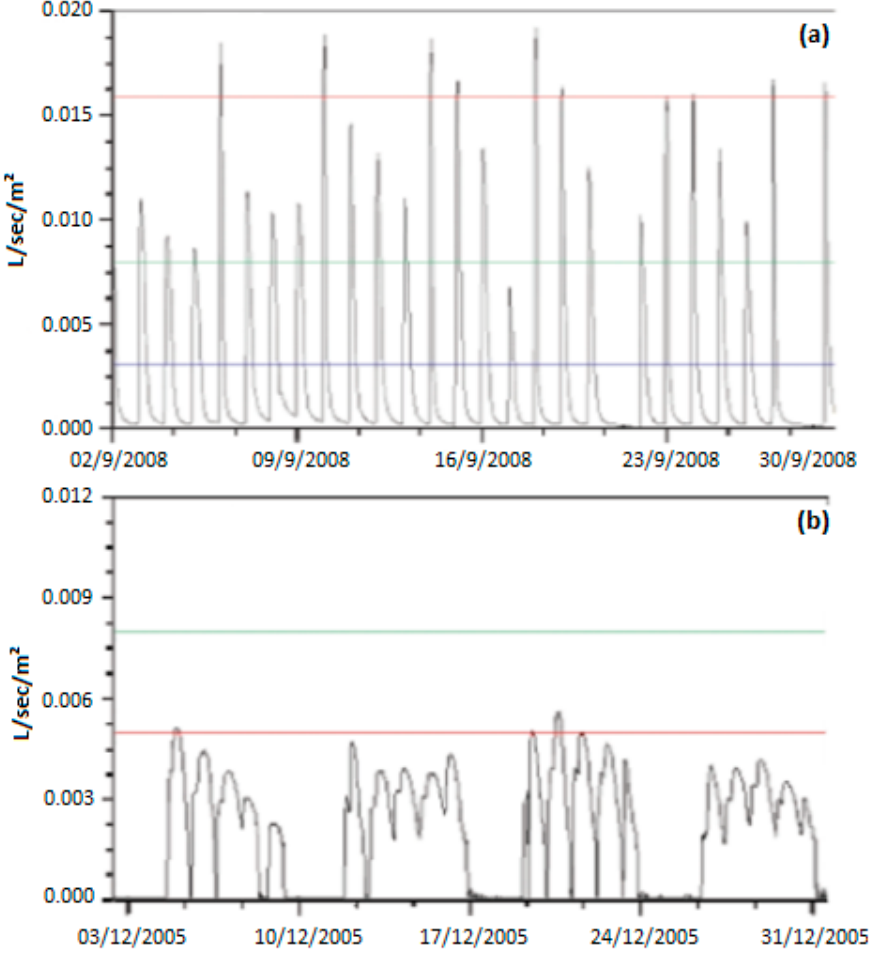
Figure 4. Infiltration rate curves at the ( a ) Helsinge STRB (domestic sludge) and ( b ) Tinglev STRB (industrial sludge) in Denmark [53]. Table 2. Dewatering efficiency of various STRBs in Denmark and Sweden treating sludge with high fat contents (P = pilot, F = full-scale).